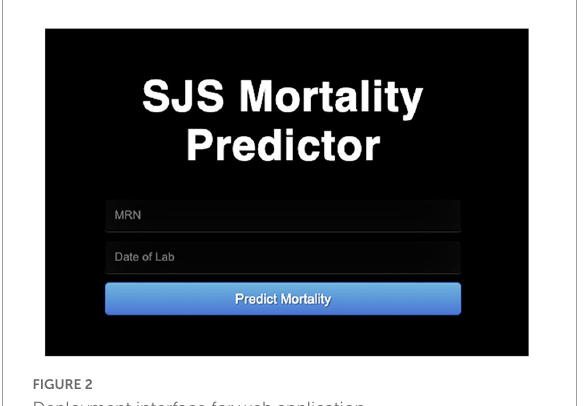
FIGURE2 Deployment interface for web